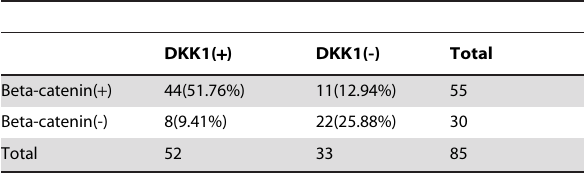
Table 2. Correlation between the expression of DKK1 and